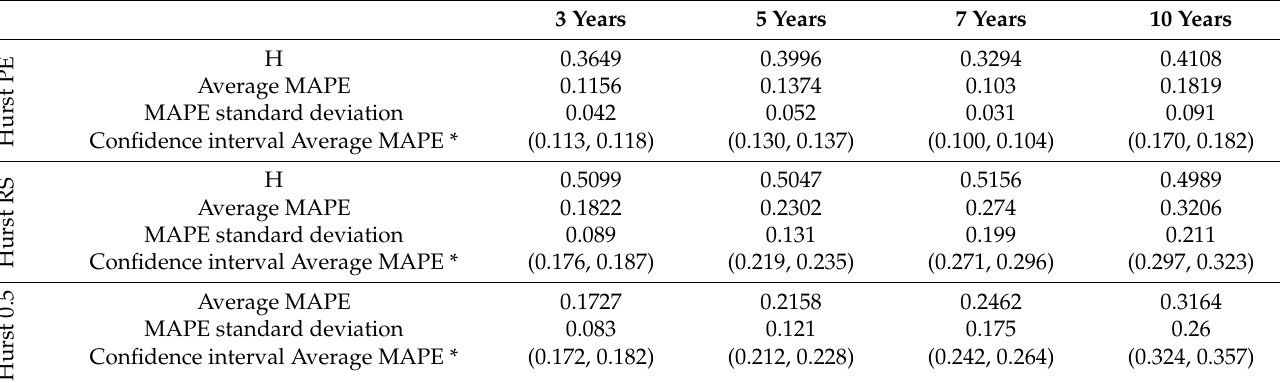
Table 3. Hurst index and MAPE results for Stoxx Eur